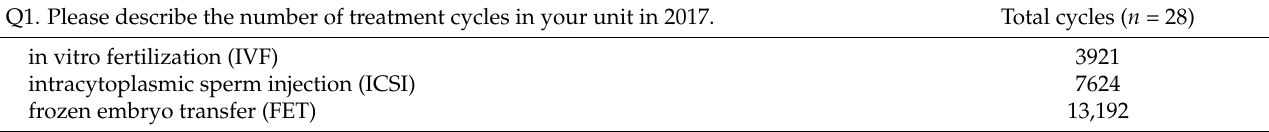
Table A3. Questionnaire and results for ART units.